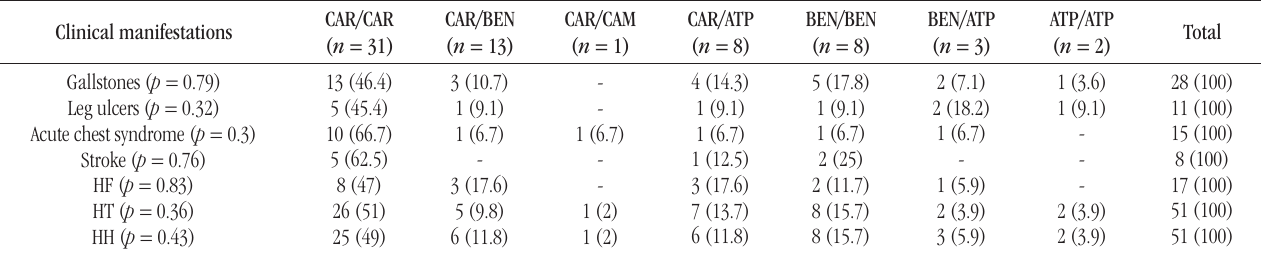
taBLE 4 − Clinical manifestations in relation to genotype (n = 61 patients)